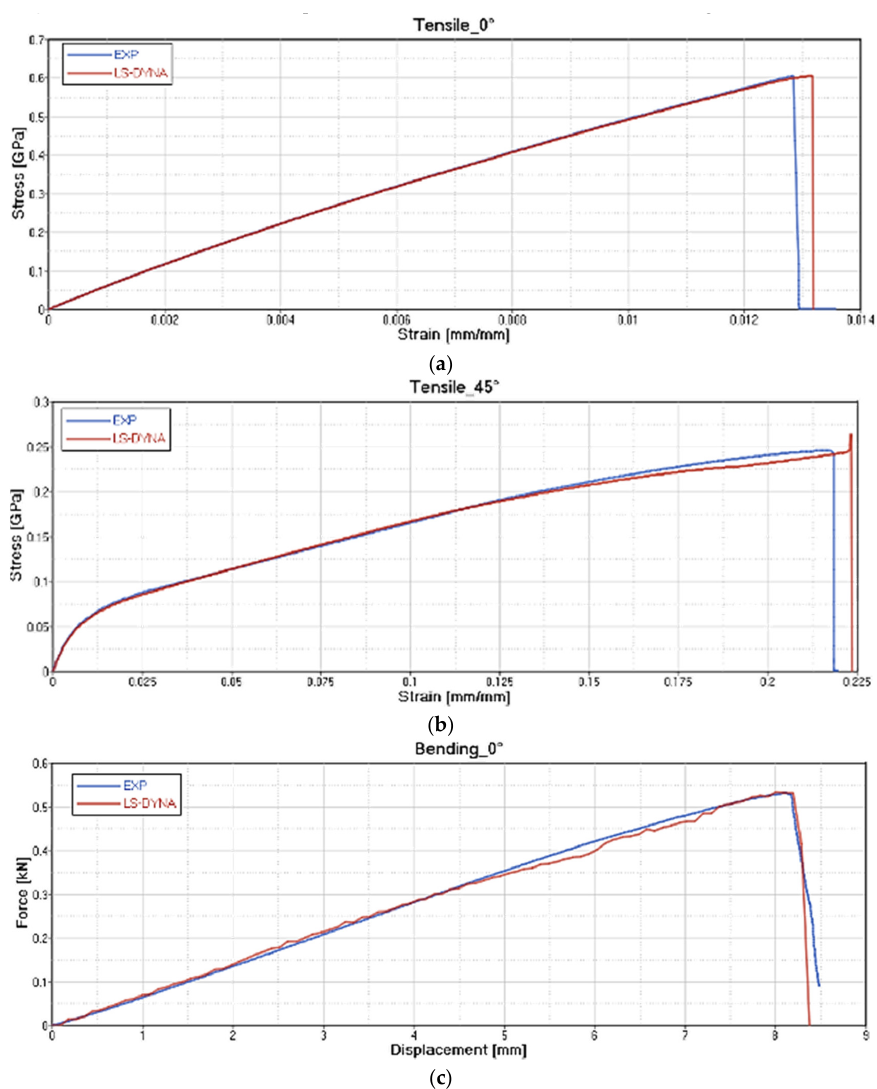
Figure 20. Correlation between experimental data and virtual material card setting f